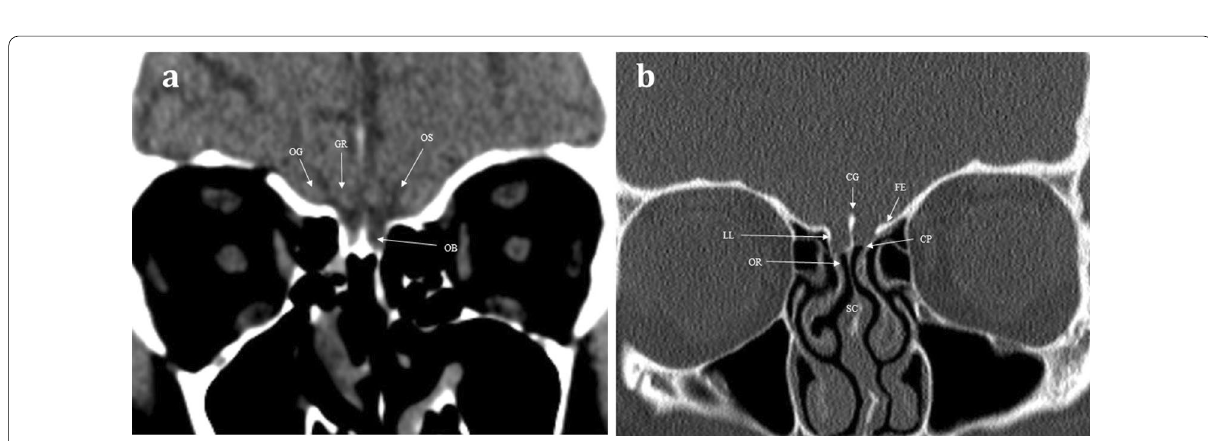
Fig. 2 Normal anatomy. Coronal soft tissue ( a ) and bone window ( b ) CT images at the level of the olfactory bulb, demonstrating the normal anatomy of the sinonasal compartment (SC) and anterior skull base. The olfactory nerves within the SC and olfactory recess (OR) ascend intracranially via perforations within the cribriform plate (CP). The CP is bounded laterally via the lateral lamella (LL), the crista galli (CG) is seen as a midline projection, and the fovea ethmoidalis (FE) forms the roof of the ethmoid. The position of the olfactory bulb (OB) within the olfactory groove is just discernible on the soft tissue window image ( a ). The gyrus rectus (GR) and orbital gyrus (OG) are separated by the olfactory sulcus